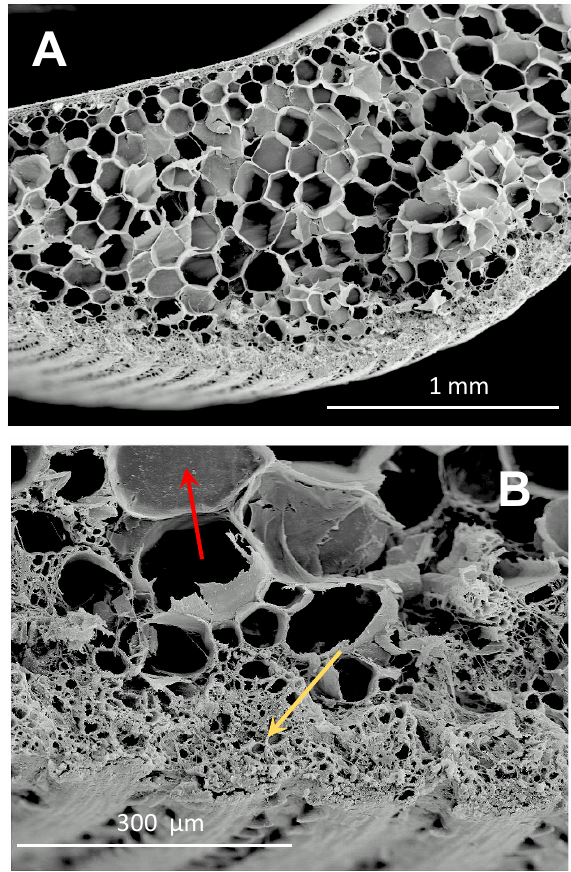
Figure 1. ( A ) SEM micrograph of a cross-section of a healthy sugar cane leaf of cv. Louisiana 55-5. ( B ) SEM micrograph of a cross-section of a smut-diseased leaf of sugar cane cv. Louisiana 55-5. In this cut, it is possible to observe some obturated xylem vessels (red arrow) and the subepidermal parenchymal tissue that was invaded by the fungal mycelium (yellow arrow).